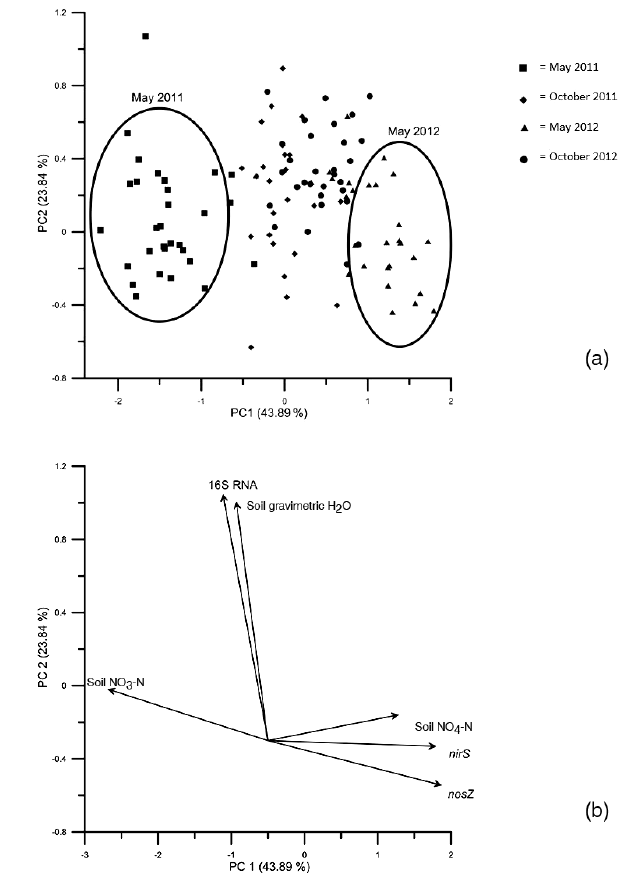
Figure 4. (a) Principal component analysis; factor 1 accounted for 43.89% variance and factor 2 accounted for 23.84% variance. (b) Loading plot for principal components of response variables ( nirS , nosZ , and 16S rRNA gene copies, as well as soil NO 3 -N, soil NH 4 -N, and gravimetric soil H 2